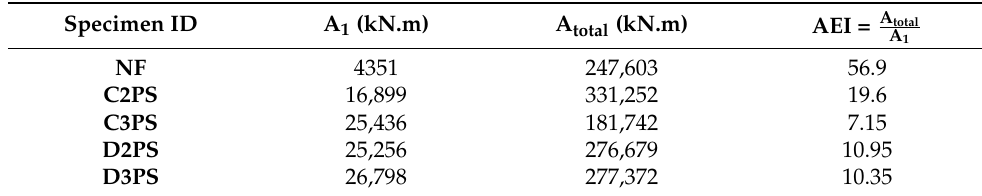
Figure 13. Area under the curve [8]. Table 7. Absorbed energy index for all tested specimens.